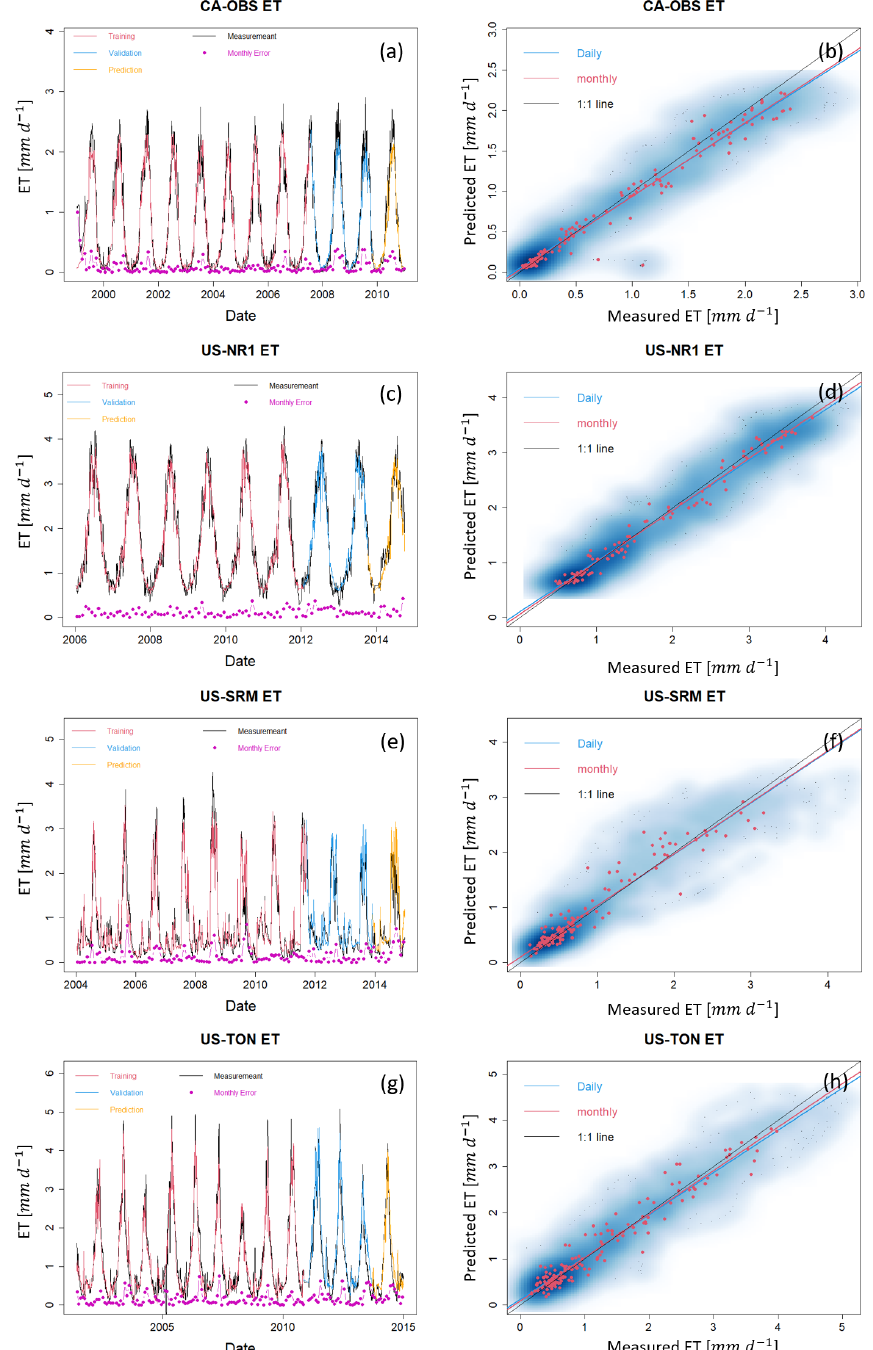
Figure A1. ET estimation with data from selected FLUXNET sites at CA-OBS, US-NR1, US-SRM, and US-Ton. Panels (a) , (c) , (e) , and (g) present daily estimations of ET separated for training, validation, and prediction. Pink points depict monthly error between HPM estimation and FLUXNET data. Panels (b) , (d) , (f) , and (h) show the scatter plots of daily (blue) and monthly (red) ET. Darker blue clouds represent a greater density of data